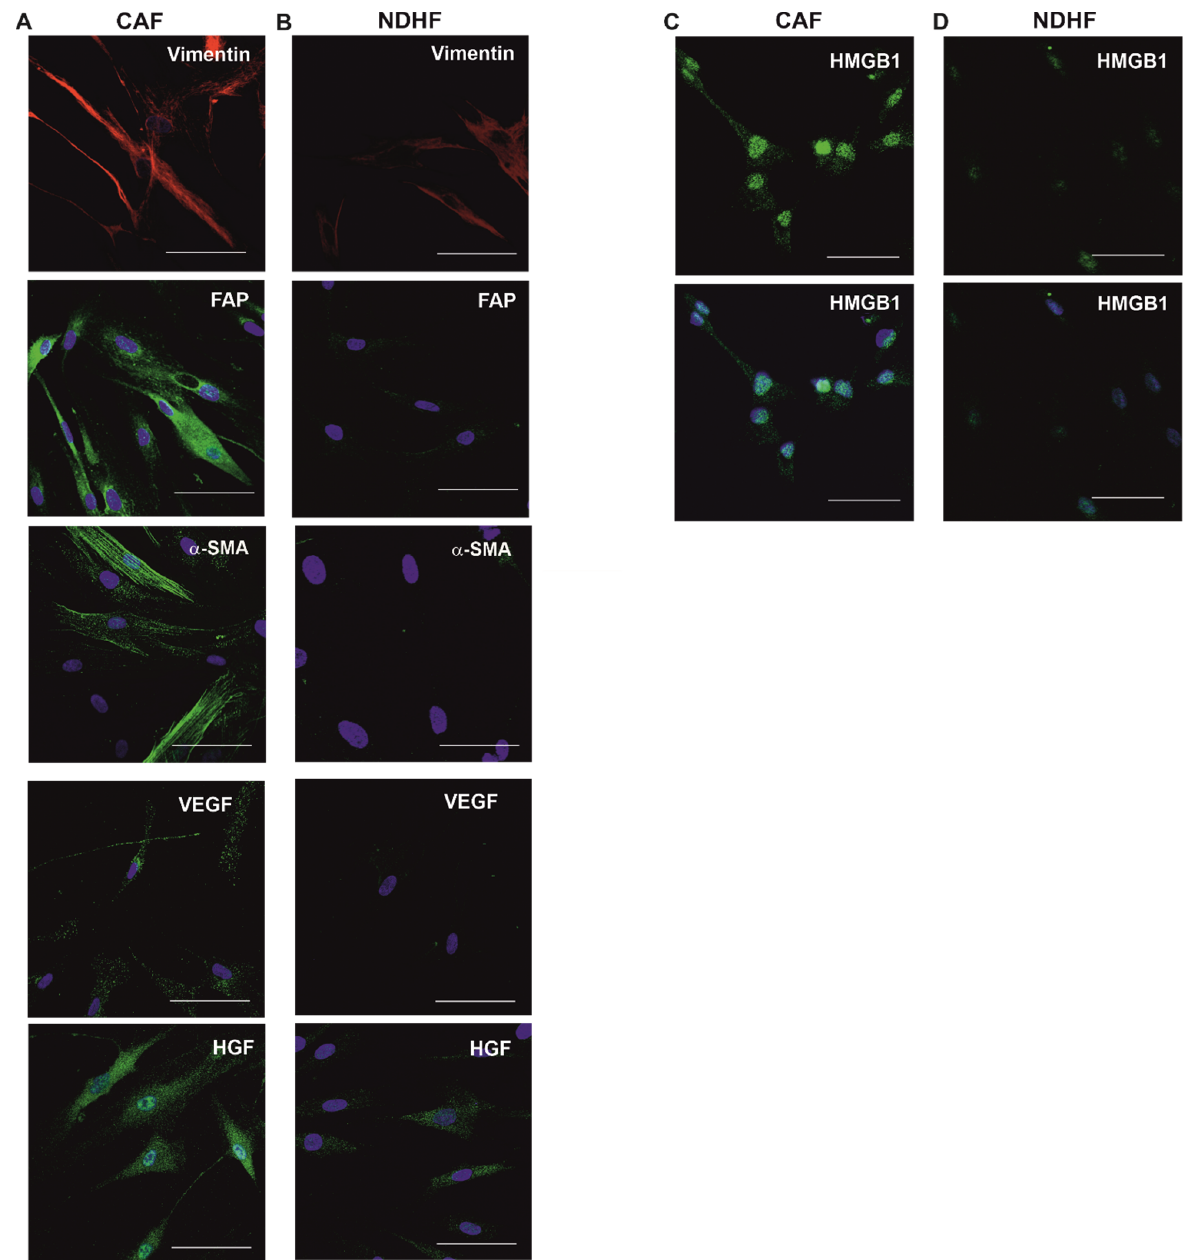
Figure 1. Activation profile of CAFs and NDHFs. CAFs ( A ) display a higher level of expression of the proteins associated with fibroblast activation compared to NDHFs ( B ). Vimentin (red); FAP, α -SMA, VEGF and HGF (all green), DAPI (blue). ( C , D ) Positive cytoplasmic staining for the DAMP protein, HMGB1, in CAFs ( C ) and negative staining in NDHFs ( D ); HMGB1 (green) upper panel, HMGB1 (green) and DAPI (blue) lower panel. Scale bars, 50 μ m.